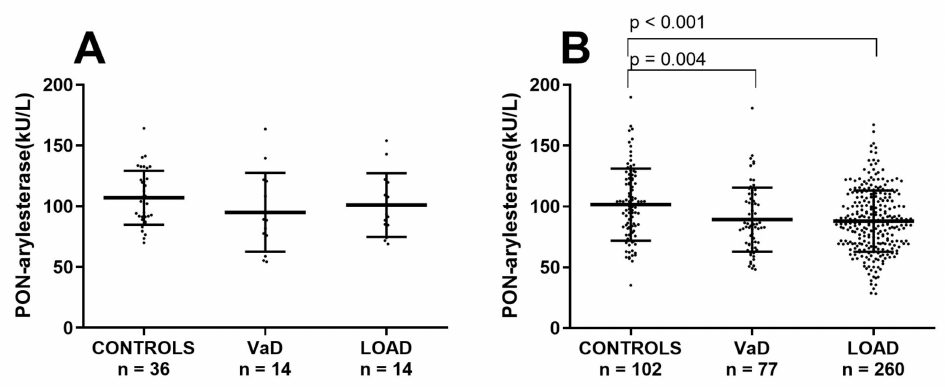
Figure 3. Scatter plots displaying serum PON-arylesterase activity in ( A ) CONTROLS ( n = 36), VaD ( n = 14), and AD ( n = 14), within the younger subset of FC; ( B ) CONTROLS ( n = 102), VaD ( n = 77), and AD ( n = 260) within the older ( > 71 years) subset of FC. Statistical analysis was performed using ANOVA followed by Sidak post-hoc test. Abbreviation: VaD, vascular dementia; LOAD, late